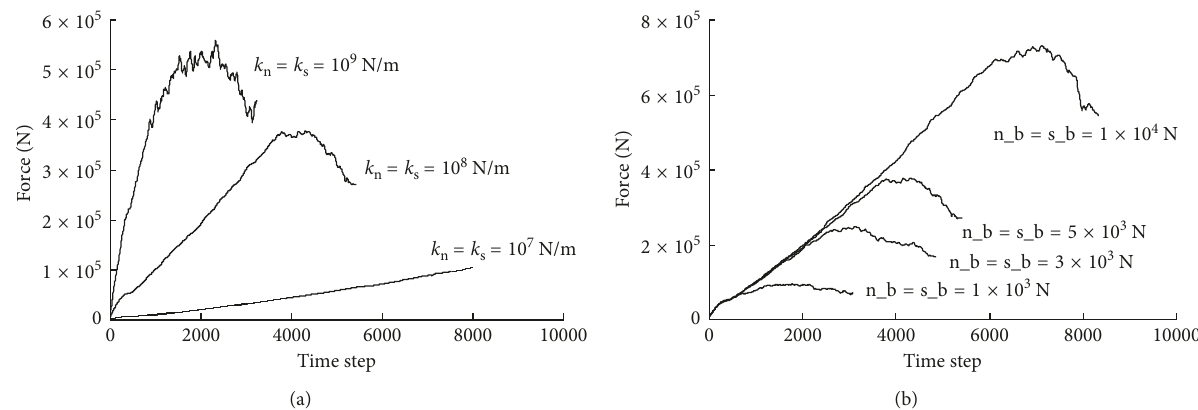
Figure 6: Effect of the contact bond model parameters. (a) Effect of stiffness. (b) Effect of bond strength [27].